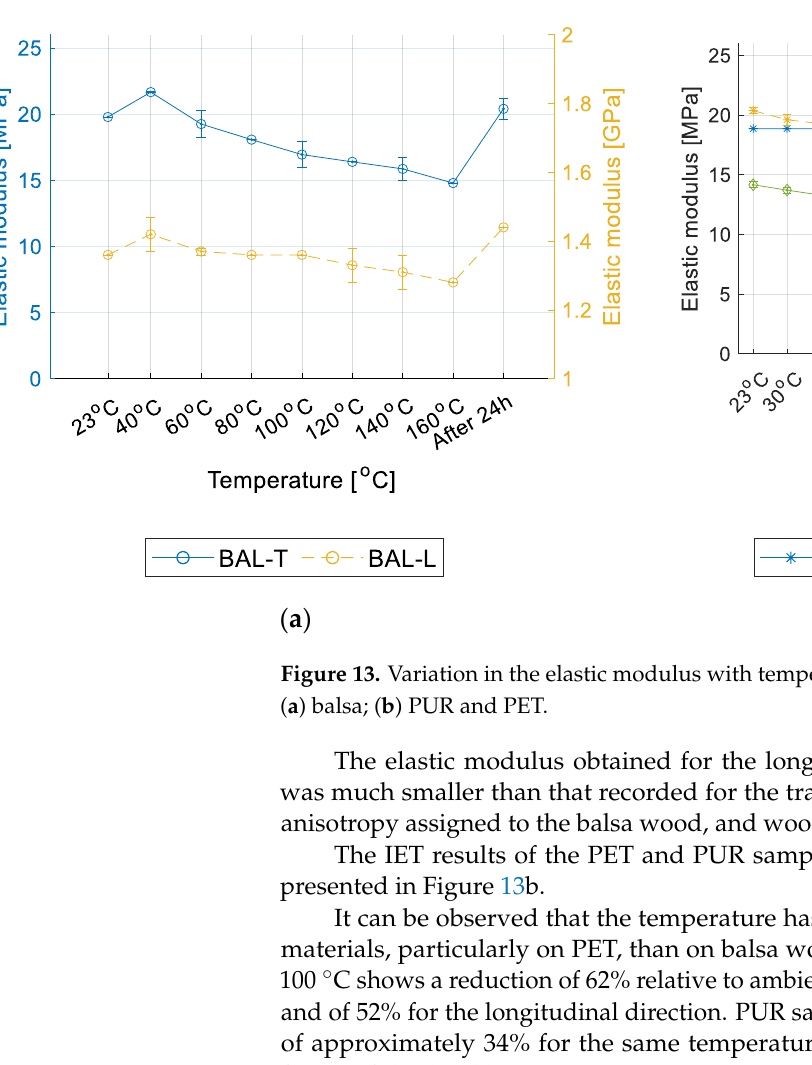
Figure 12. Example of a recorded signal obtained with the specimen PET-T at 70 °C: ( a ) in time domain; ( b ) in frequency domain.